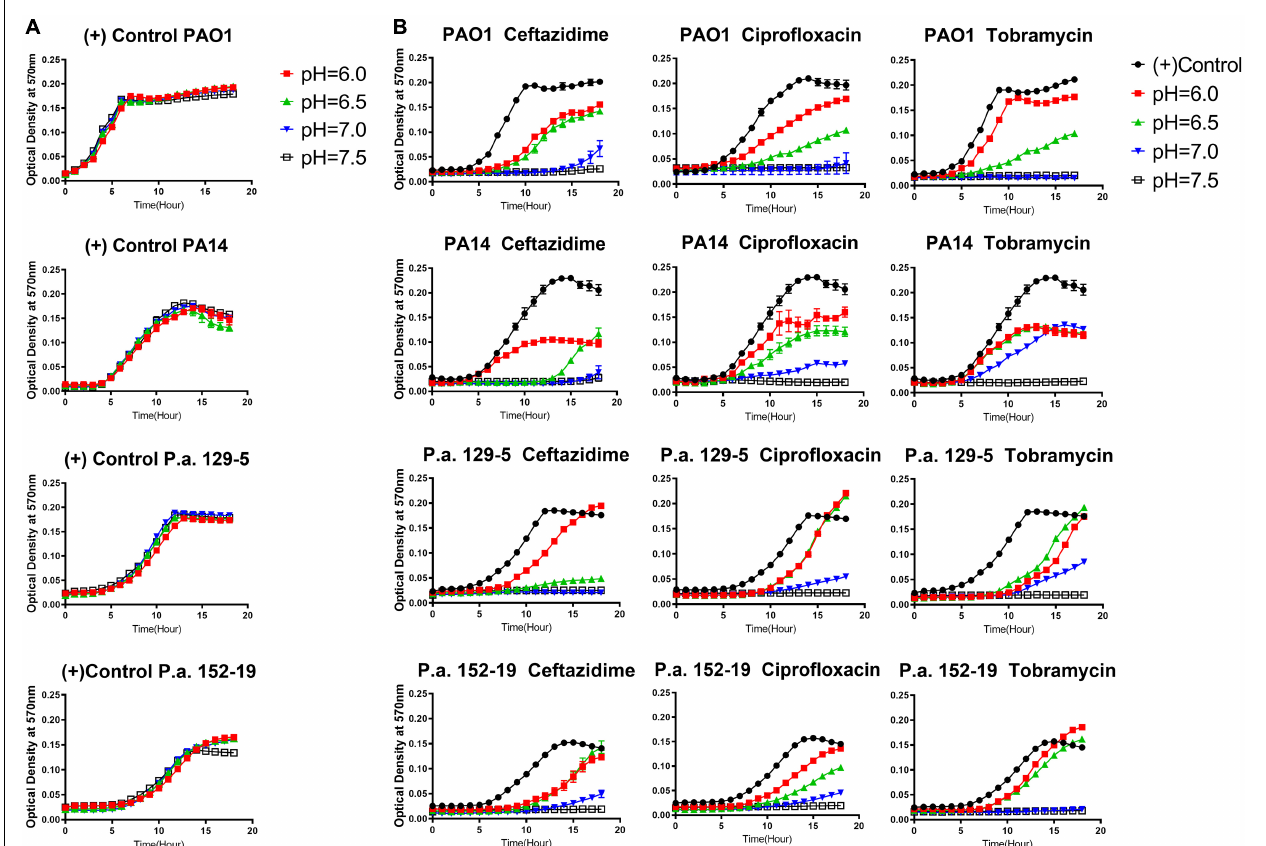
FIGURE 1 | Acidic pH conditions impair the antimicrobial activity of standard-of-care antibiotics against P. aeruginosa . (A) P. aeruginosa growth curve in pH adjusted, antibiotic-free medium. (B) P. aeruginosa growth curve in pH adjusted medium, supplemented with ceftazidime, ciprofloxacin, and tobramycin at the respective MIC for each antibiotic at pH 7.5. A pH-adjusted 10% TSB medium was used in this experiment. Optical density at 570 nm was measured every hour for 18 h at 37 ◦ C in a microplate reader. A closely fitted lid was placed on the microplate to prevent liquid evaporation. No samples were placed near the edge of the 96-well microplate to prevent any drying effect during overnight incubation. Results are mean ± SEM from three independent experiments with bacteria grew in duplicates for each condition.